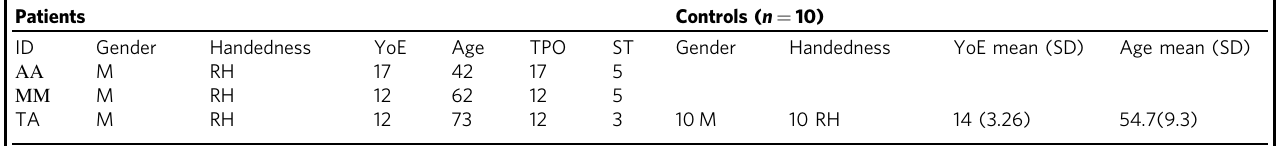
Table 3 Demographic data of the three patients and the control group.